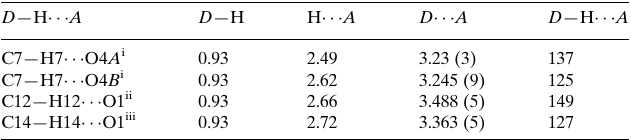
Hydrogen-bond geometry (A˚ , (cid:2)